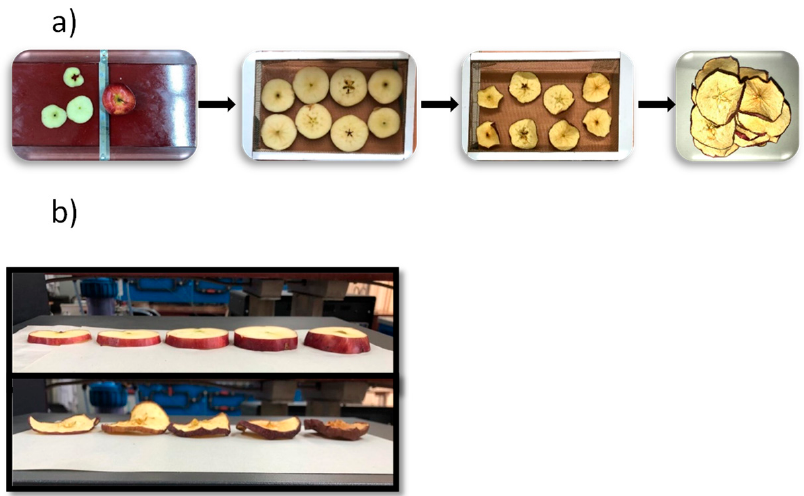
Figure 1. Sample preparation: ( a ) a sample batch with 6 mm apple slices, and ( b ) slices with di ff erent thicknesses.